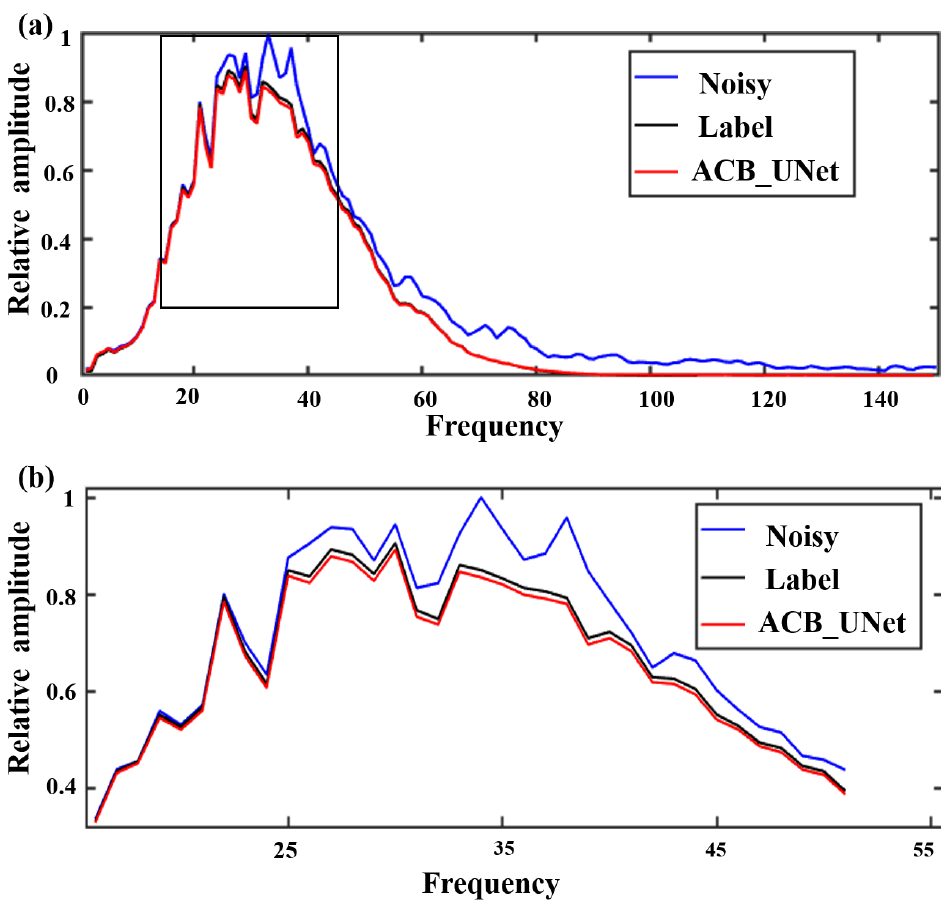
Figure 11. ( a ) Amplitude spectra of Figures 8a,c and 9e; ( b ) enlarged rectangular area in ( a ).